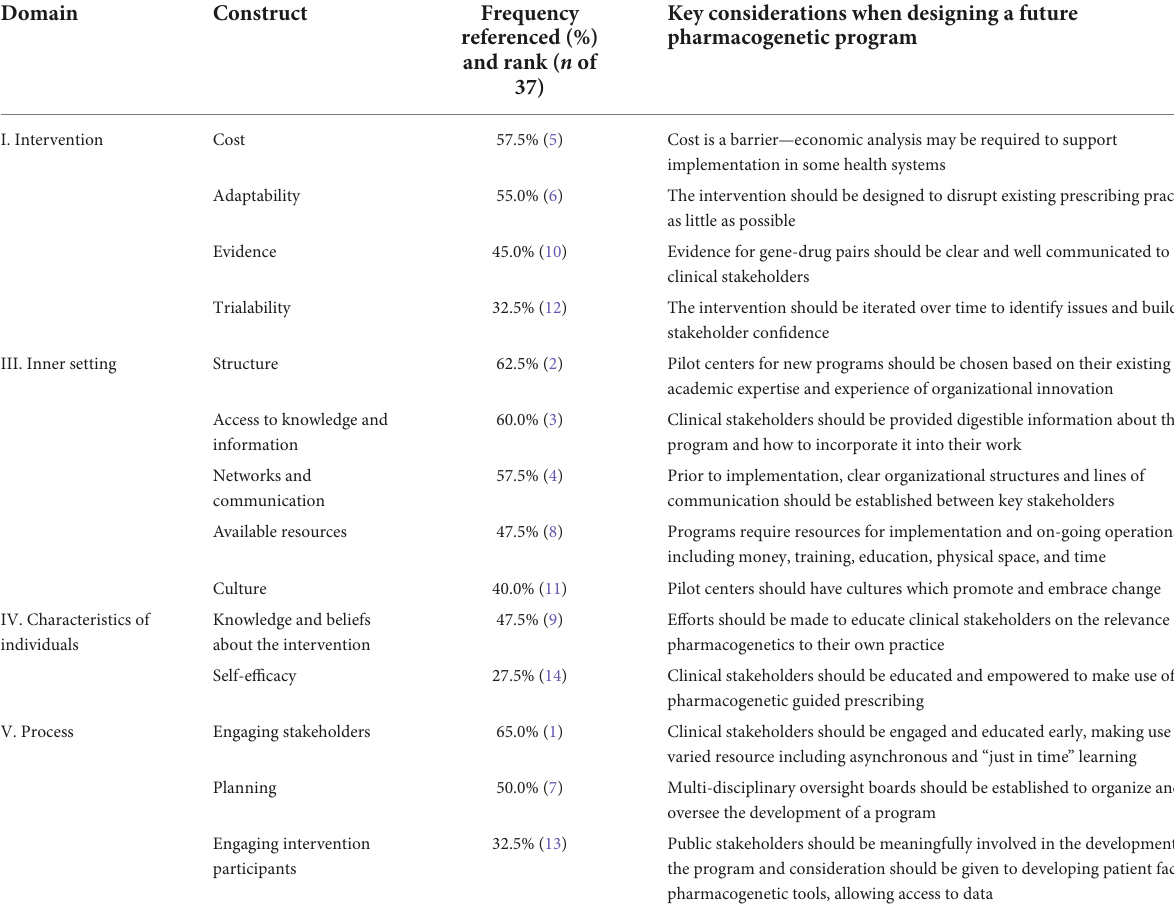
TABLE 1 The most highly referenced CFIR